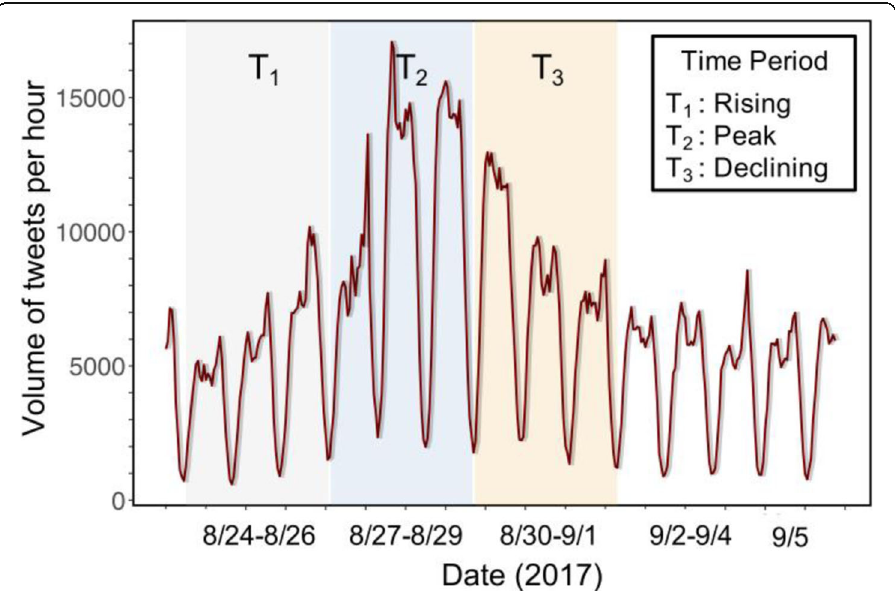
Fig. 5 The density distribution of tweeting activities per hour by active users. The y-axis is the absolute value of the tweets volume per hour. Three time periods, rising period (T 1 ), peak period (T 2 ), and declining period (T 3 ), are determined by the volume of tweets with the same length of duration (3 days) in order to make the analysis more concise and